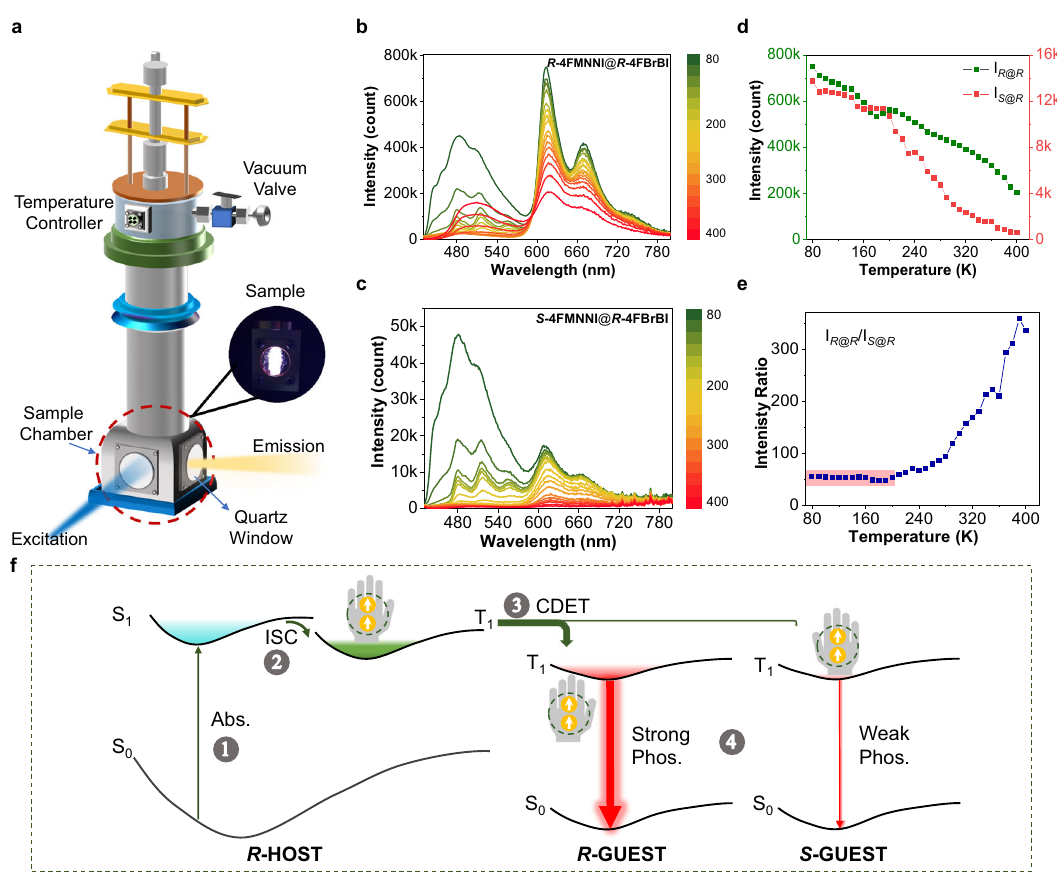
Fig. 3 | Temperature-dependent spectroscopy exploration and mechanism perspective. a Cryostat equipment for measuring temperature-dependent delayed emission (TDDE) spectra. b , c Temperature-dependent delayed emission ( Δ t =0.1ms, TDDE) spectra of R − 4FMNNI ( b ) and S − 4FMNNI ( c ) in the R − 4FBrBI solid (namely, R @ R and S @ R , 10 ppm, λ ex =424nm), from 80K to 400K with 10K intervals (for simplicity, b , c only display 20K intervals, 10K interval spectra are shown in Figures S15-S16). d Intensity at 615nm obtained from b and c . vs. temperature. e The ep ( I R @ R / I S @ R ) values vs. temperature. Note that ep remains almost constant below 200K with a high value of approximately 50. f A plausible chirality-dependent energy transfer (CDET) process for the chiral-selective RTP enhancement (CPE) phenomenon. When the samples are excited, the